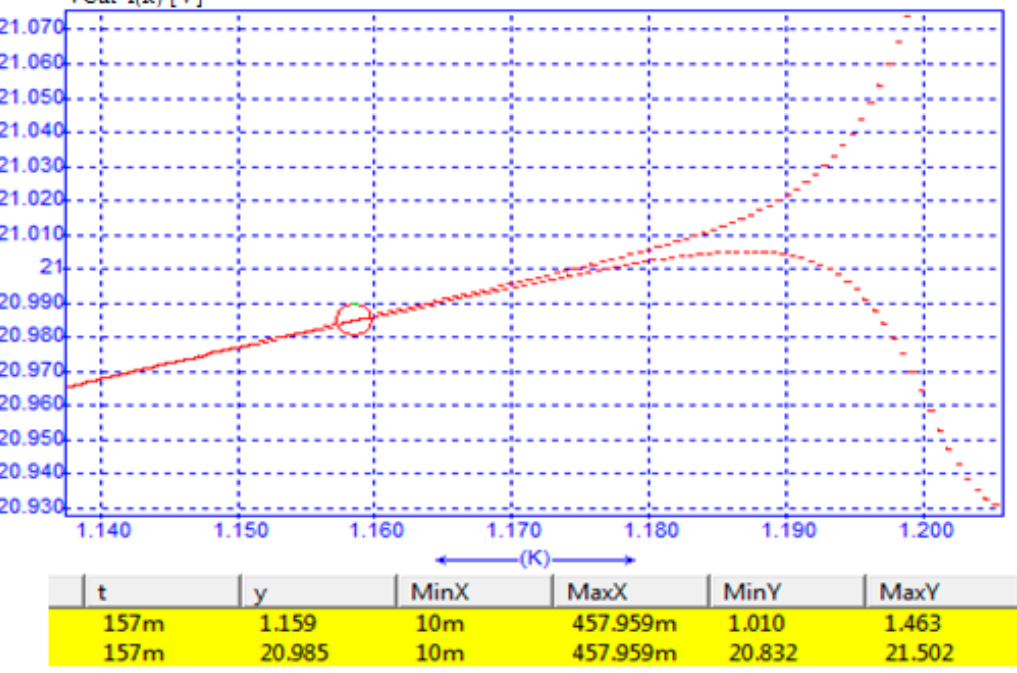
Figure 6. Magnified image around the bifurcation point. Clearly bifurcation appears at k = 1.159. The table below provides the instantaneous values of the simulated waveforms, together with their minimum and maximum values.